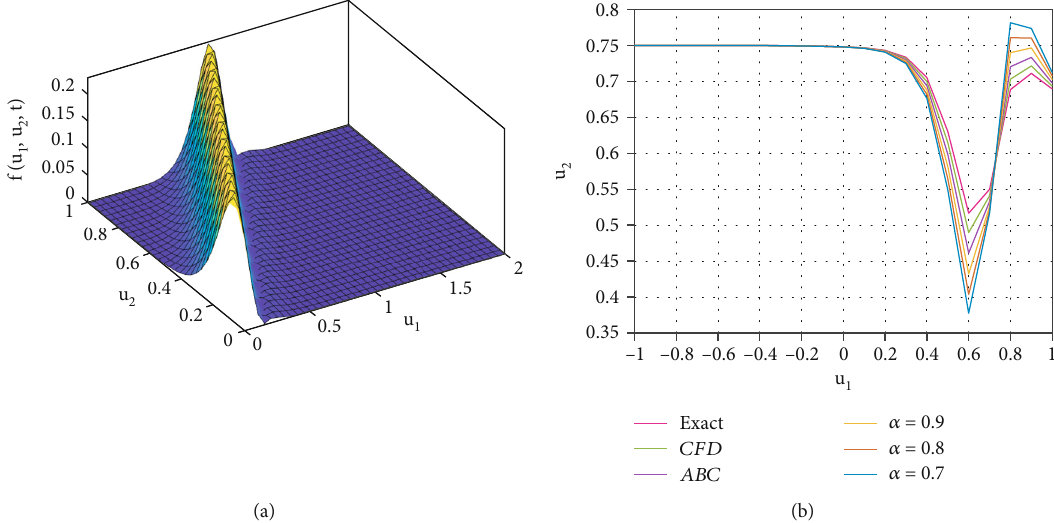
: u t Þ when δ 1 , 2 , 1 = 1